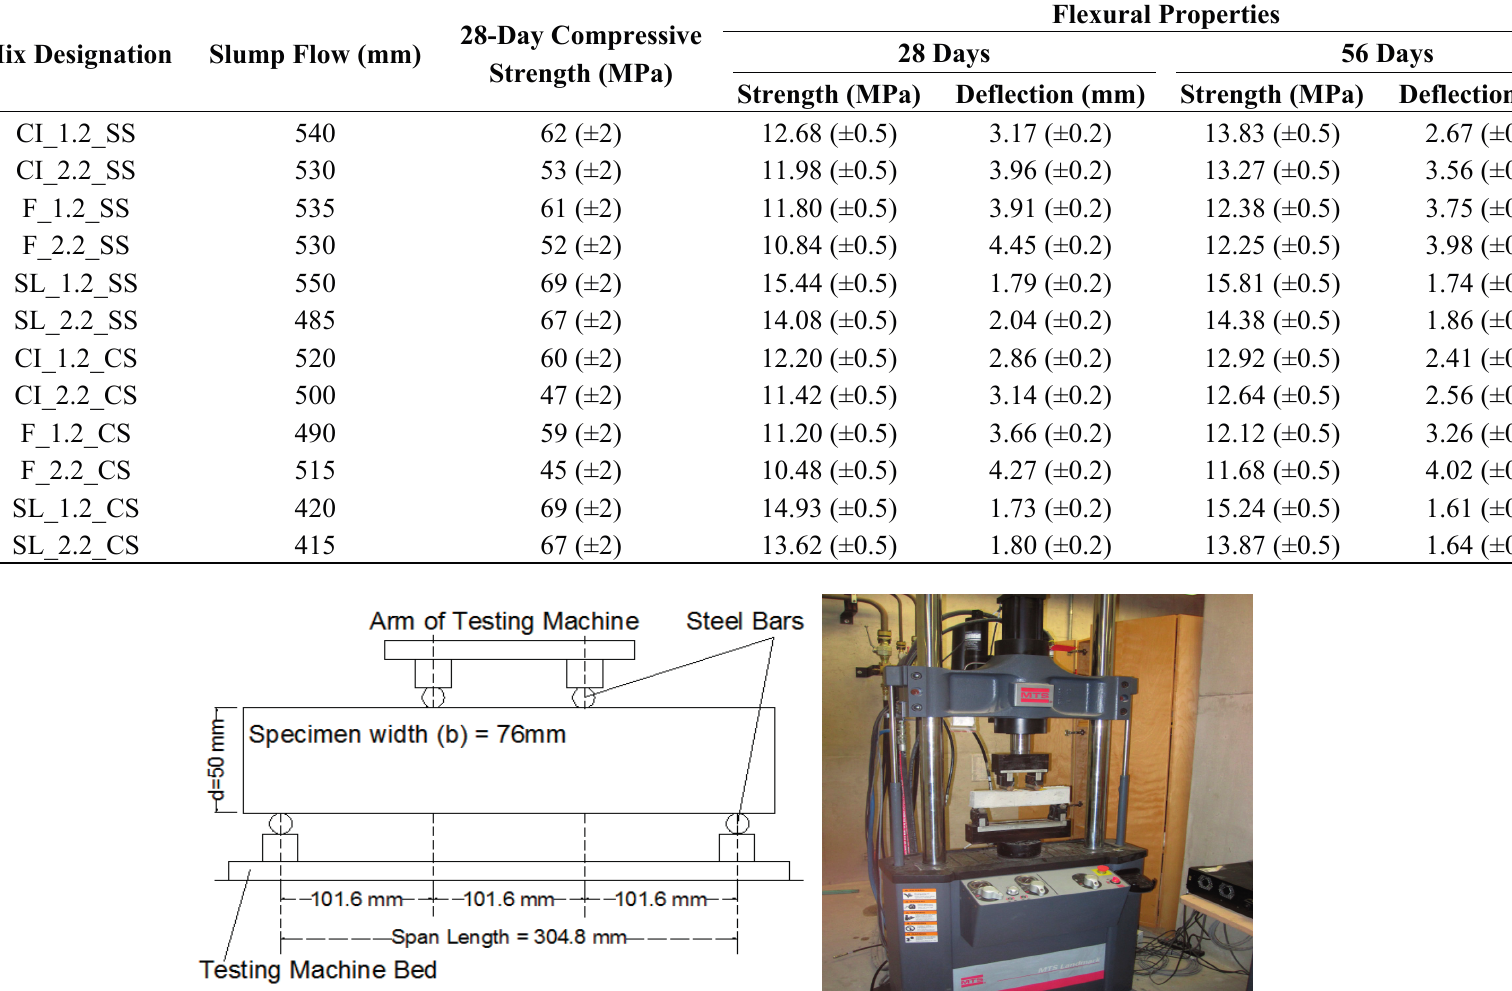
Table 4. Average flexural strength and ultimate deflection results at ages 28 and 56 days.